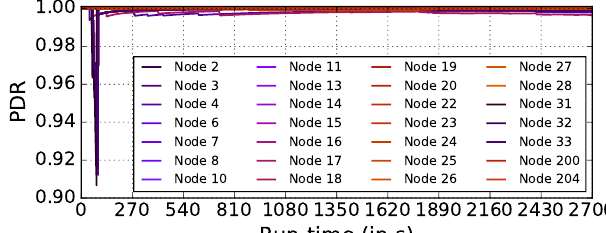
Figure 11. PDRs of all nodes in FlockLab changing over run- time. PDR drops during the greedy exploration phase while finding all the absorbing nodes, but it is still higher than 90%.